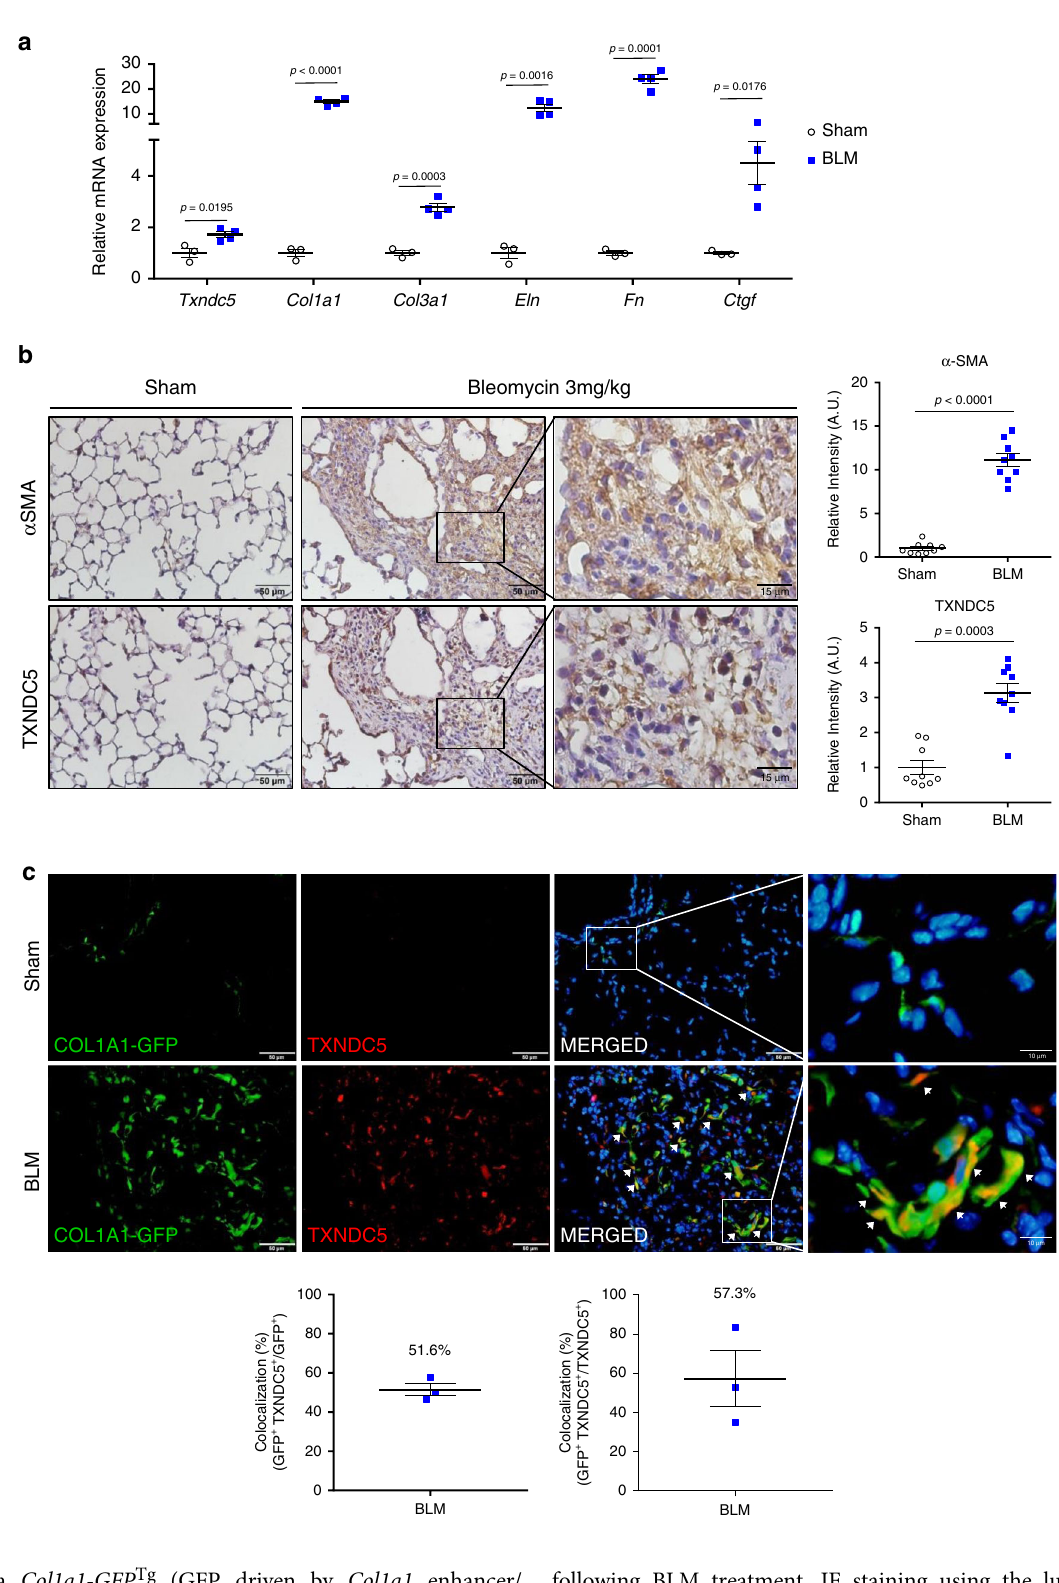
following BLM treatment. IF staining using the lung sections from a BLM-treated, tamoxifen-inducible transgenic mouse line Tie2-Cre/ERT2 * ROSA26-tdTomato ( Tie2-tdTomato ) that allows the visualization of endothelial cells with red fl uorescence protein tdTomato, showed that TXNDC5 was only expressed in ~37% of tdTomato-positive lung endothelial cells (Supplementary Fig. 2c, d). In addition, IF staining showed that TXNDC5 did